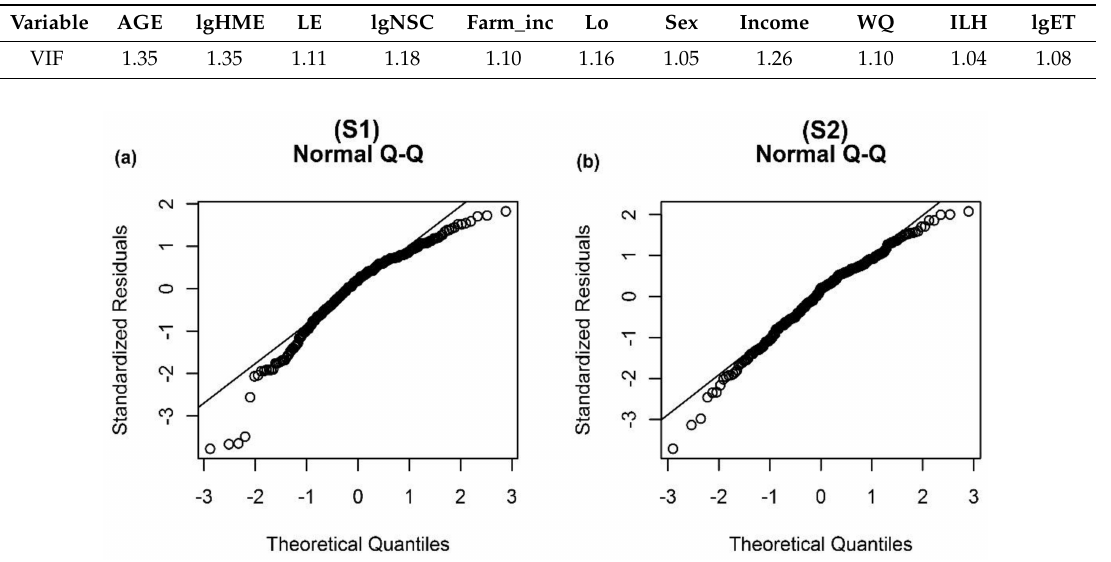
Table 3. Variance Inflation Factor of variables used in the model.